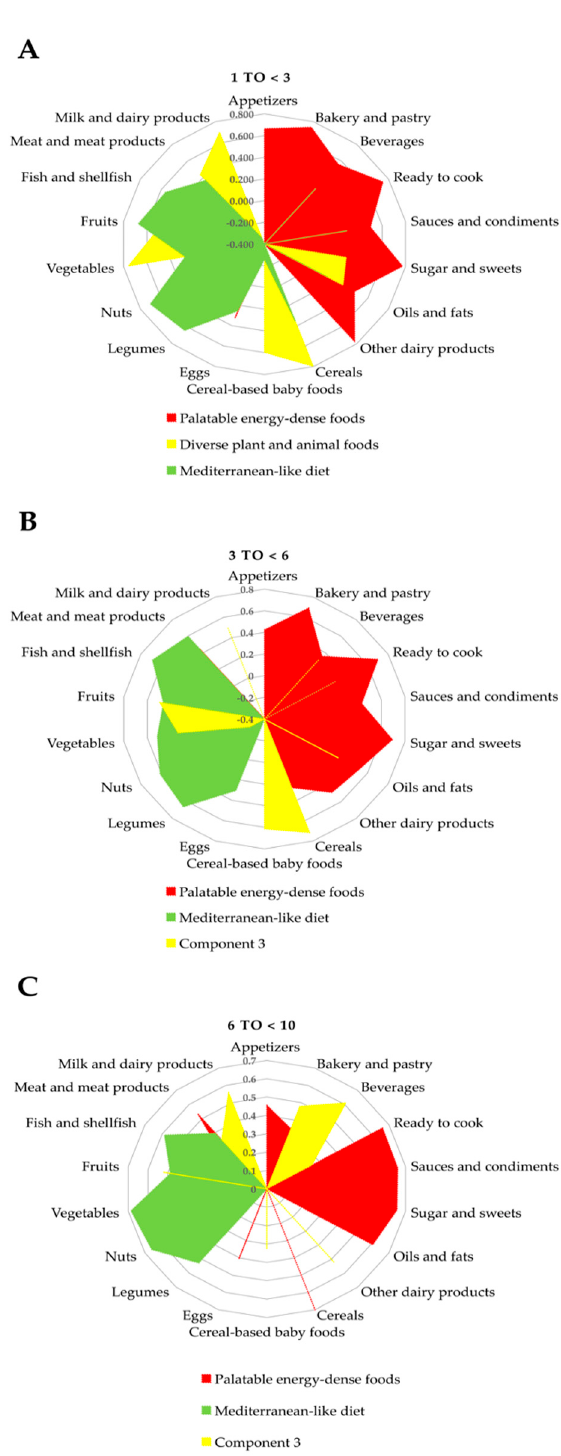
Figure 1. Dietary patterns extracted from principal component analysis of 18 major food groups in a representative cohort (SRS) of the EsNuPI ( n = 740). ( A ). Children from 1 to < 3 years ( n = 169), ( B ). children from 3 to < 6 years ( n = 256), and ( C ). children from 6 to < 10 years ( n = 315).